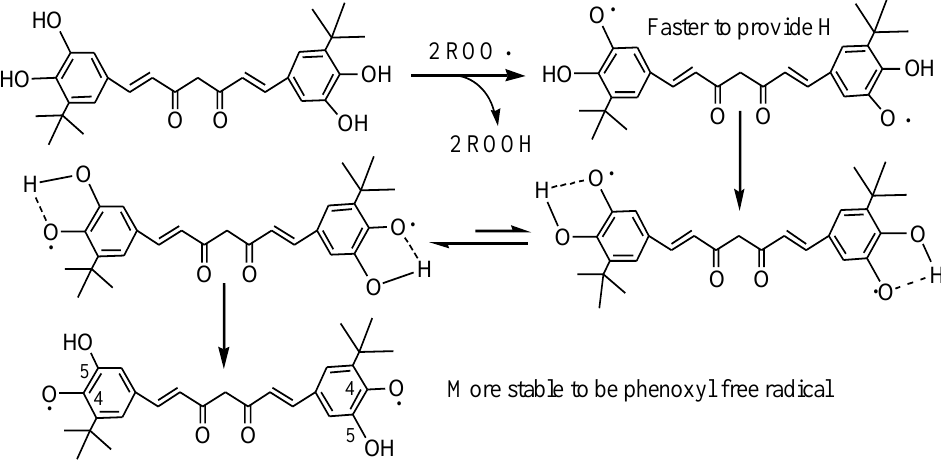
Scheme 3. Elucidation of the synergistic effects of ortho -hydroxyl groups on DMTC.